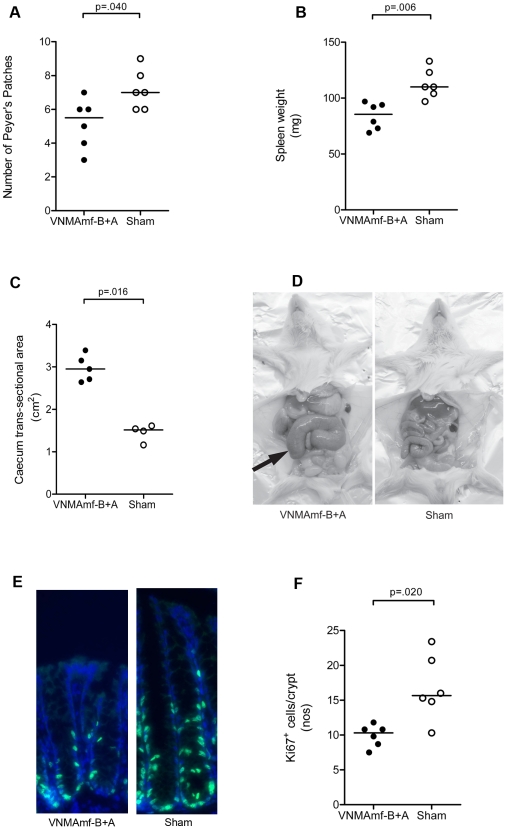
Mice subjected to antibiotic gavage treatment alters macroscopic phenotype and epithelial proliferative activity.Numbers of macroscopically visible Peyer's patches (A), spleen weight (B), and cecal longitudinal cross section area (C), after 17 days of treatment with vancomycin (V), neomycin (N), metronidazol (M), and amphotericin-B (Amf-B) every 12 hours by gavage with ampicillin ad libitum in drinking water (A) compared to mice gavaged with water only (Sham). All VNMAmf-B+A treated mice exhibited successful depletion of cultivable intestinal microbiota (<1 cfu/mg feces). (D) Photograph of VNMAmf-B+A and sham fed mice. Note the enlarged cecum (arrow) of the antibiotic treated mouse. (E) Immunofluorescent staining for Ki67 (green) and DNA (Hoechst dye; blue) of cross sections of colons from VNMAmf-B+A fed mice and sham fed mice with (F) enumeration of Ki67+ cells per crypt. In all graphs each symbol represents one animal and horizontal bars represent medians. Statistical differences calculated by Mann-Whitney two-tailed test.